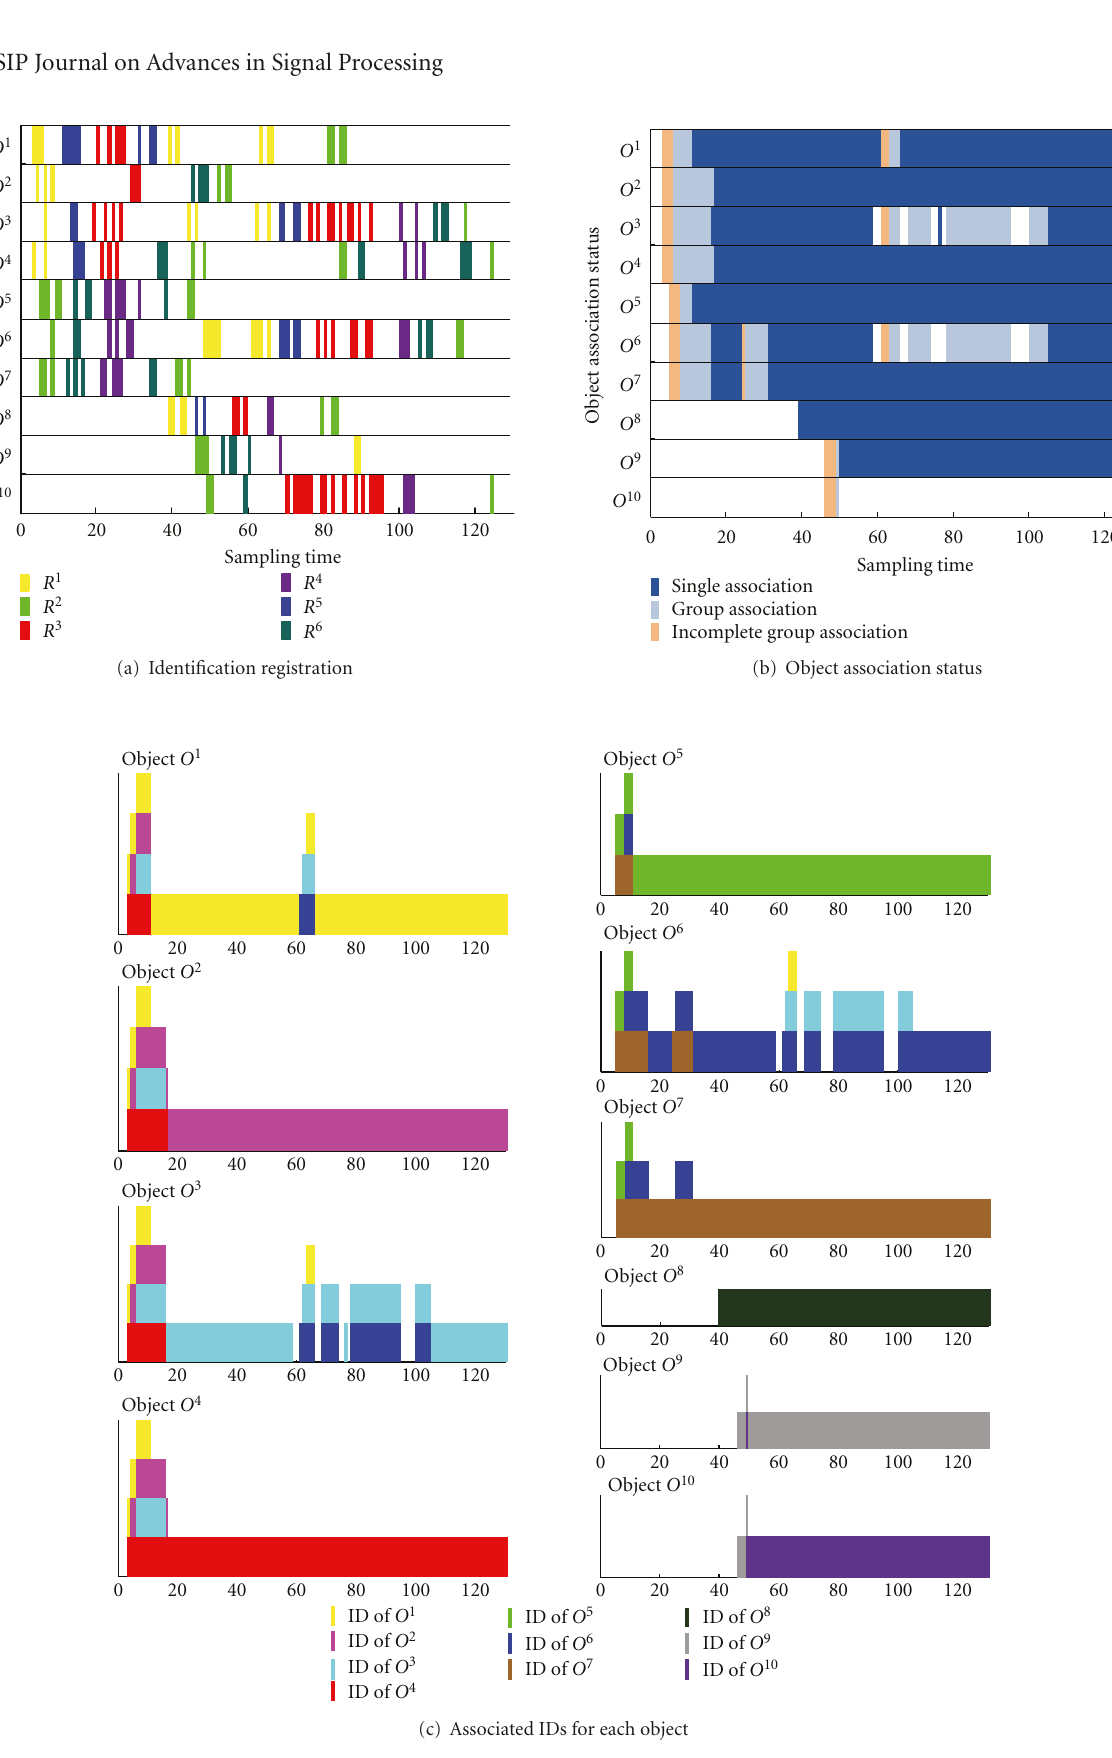
Figure 19: Object association status with the inconsistent registration of identifications when the proposed association method is